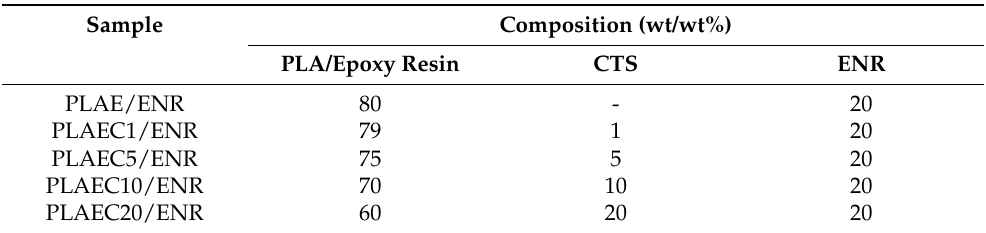
Table 1. Composition of PLAE blending with CTS and